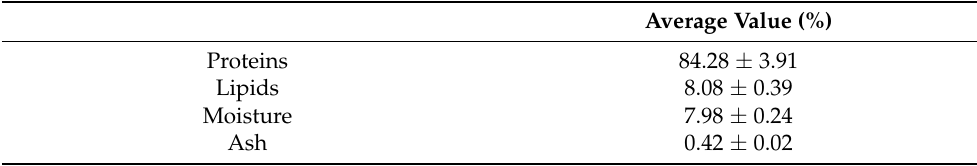
Table 1. Centesimal composition of